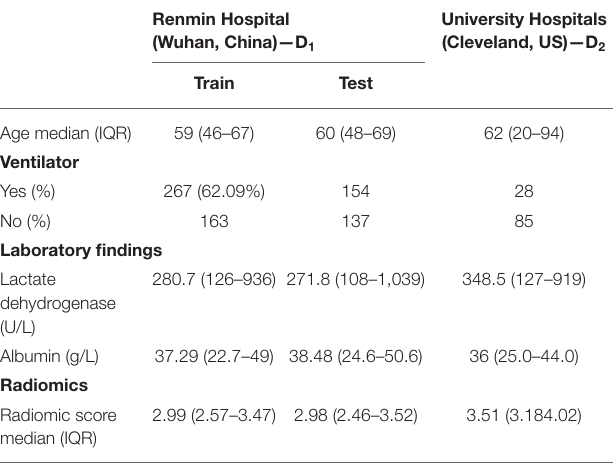
TABLE 1 | Patient characteristics.